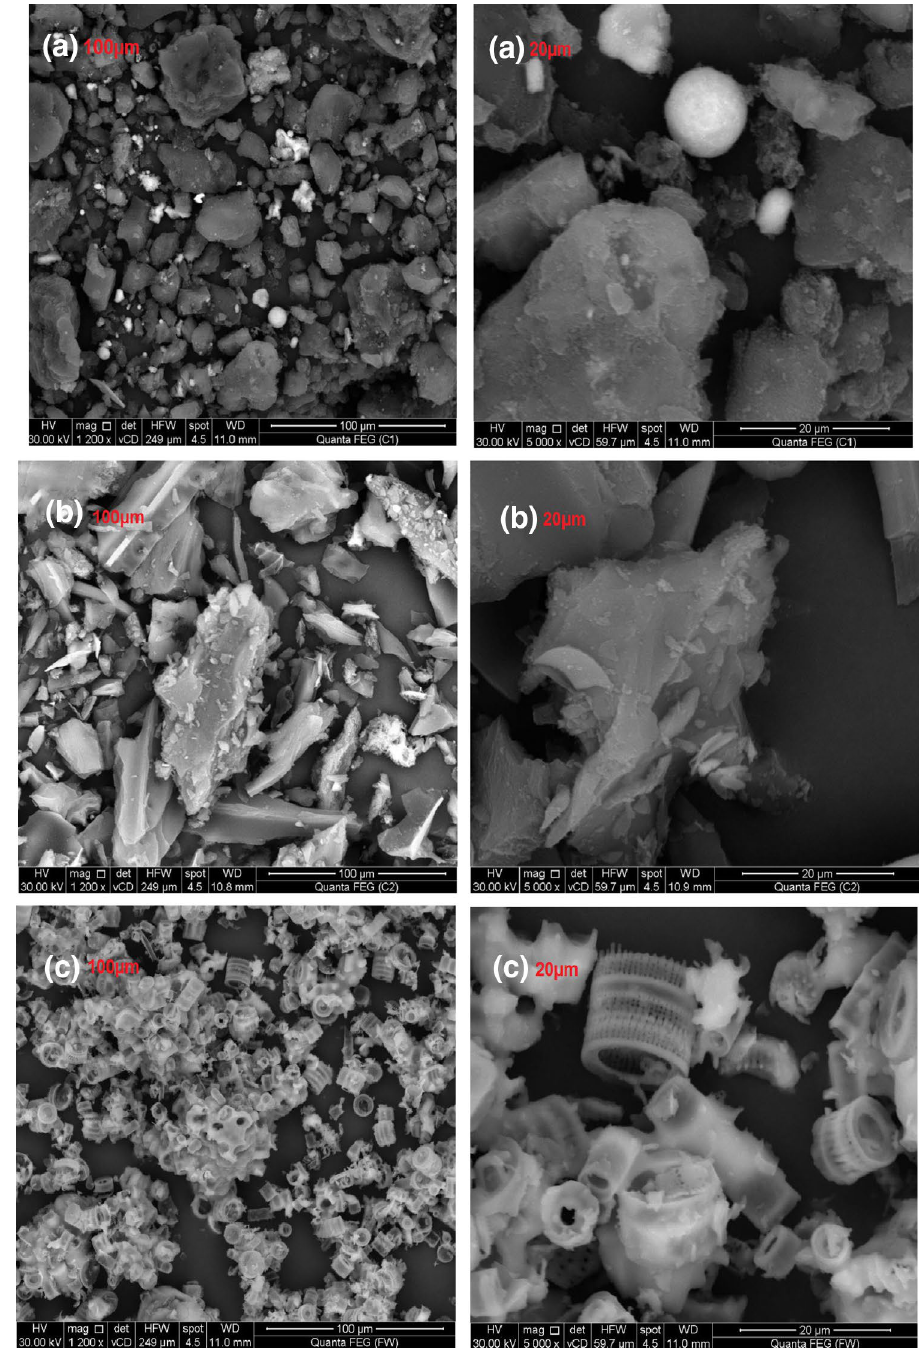
Fig. 3 Micrograph of CUA ref- erence carbon ( a ), PACW ( b ), and FW60 ( c ) at magnification 100 and 20